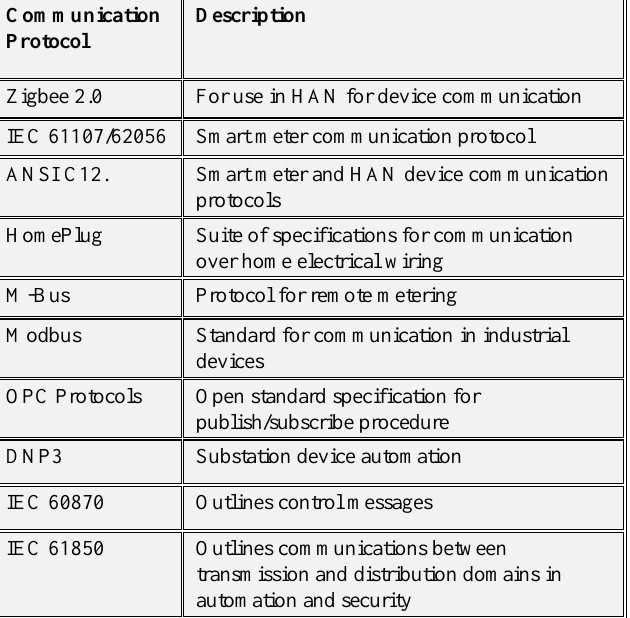
Table 2: Common Grid Communication